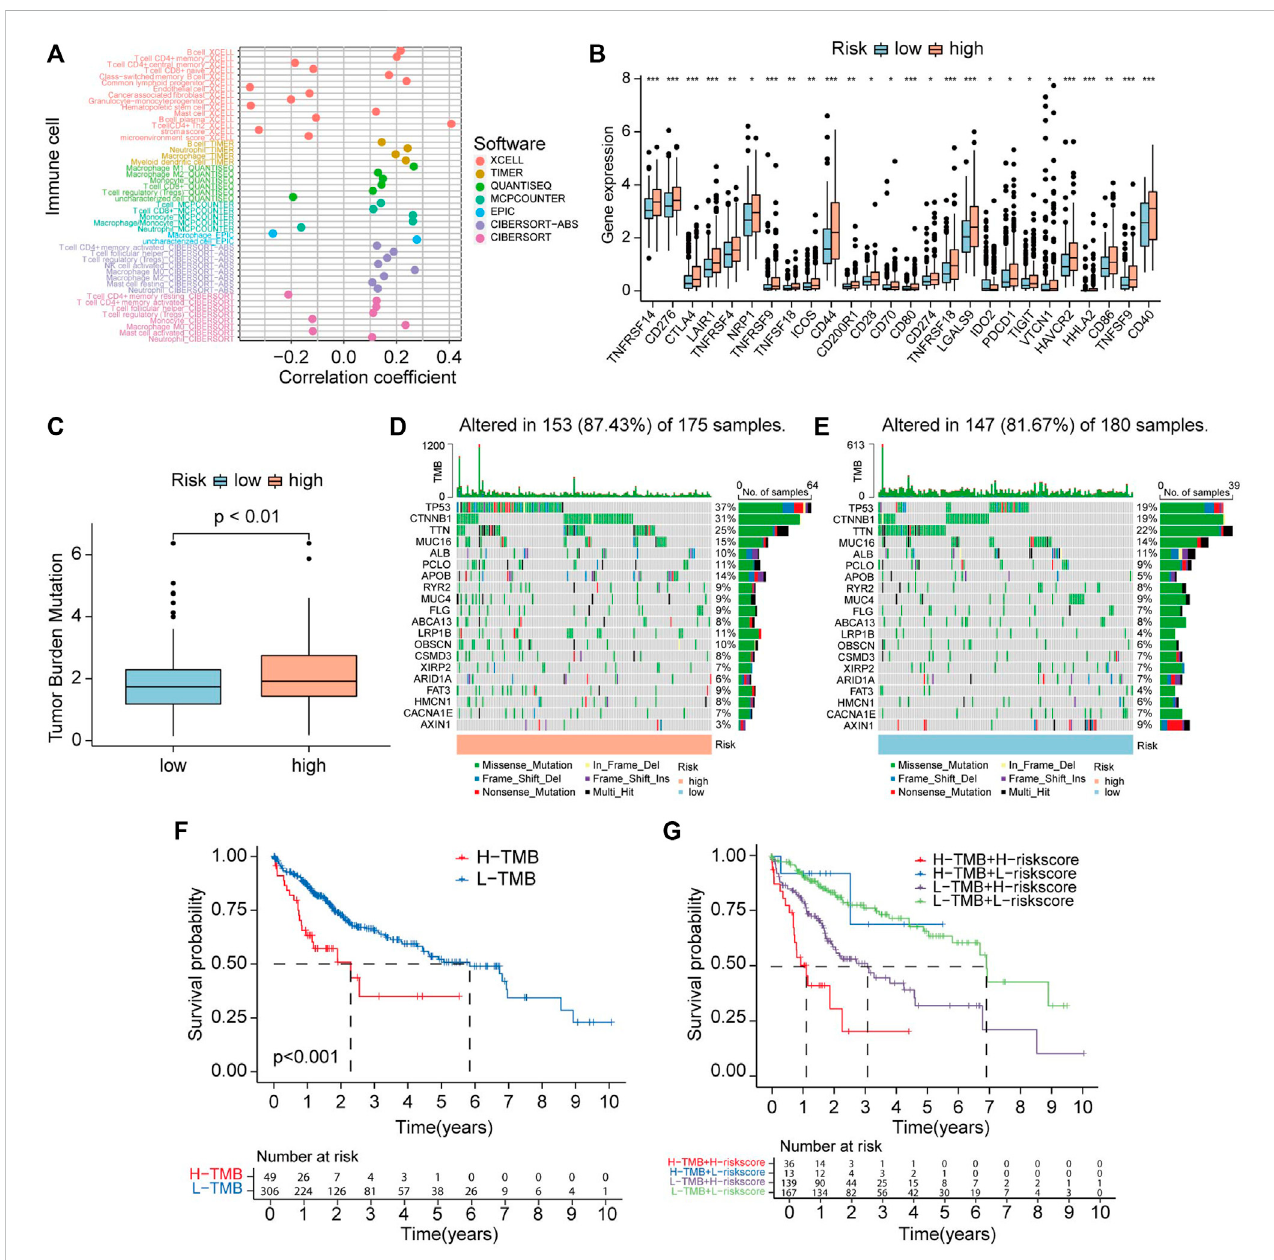
FIGURE 12 Correlation between CRLs score and immune in fi ltrating cells and tumor mutation burden (TMB). (A) Lollipop plot shows the relationship between CRLs score and immune cells analyzed by various algorithm. (B) The expression level of immune checkpoint genes in high-risk and low-risk groups. (C) TMB status in high-risk and low-risk groups. (D) OncoPrint showed the mutations status in the high CRLs score group. (E) OncoPrint showed the mutations status in the low CRLs score group. (F) The K-M curves show survival status and survival time in high-TMB and low-TMB groups. (G) Strati fi ed survival analysis, including TMB and CRLs